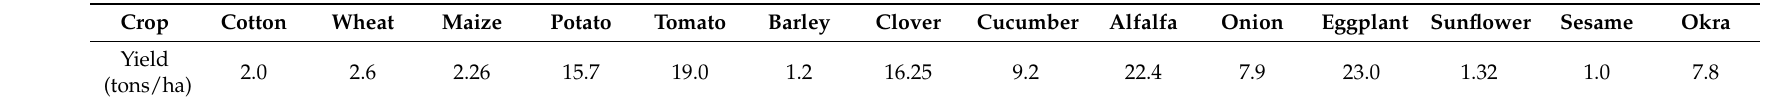
Table 3. Crop yield (tons per